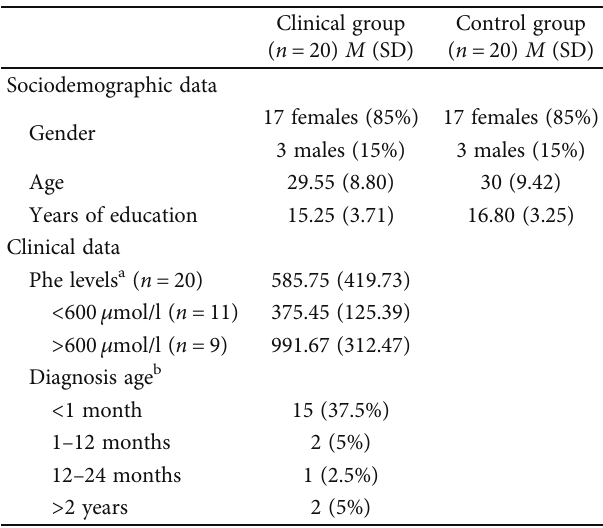
Table 1: Distribution of the sample according to sociodemographic and clinical